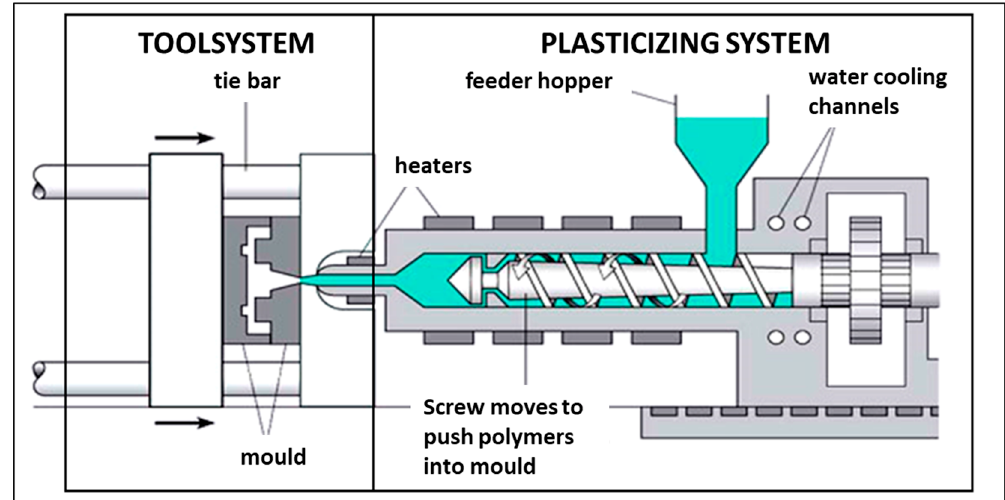
Figure 7. Injection moulding machine construction diagram.